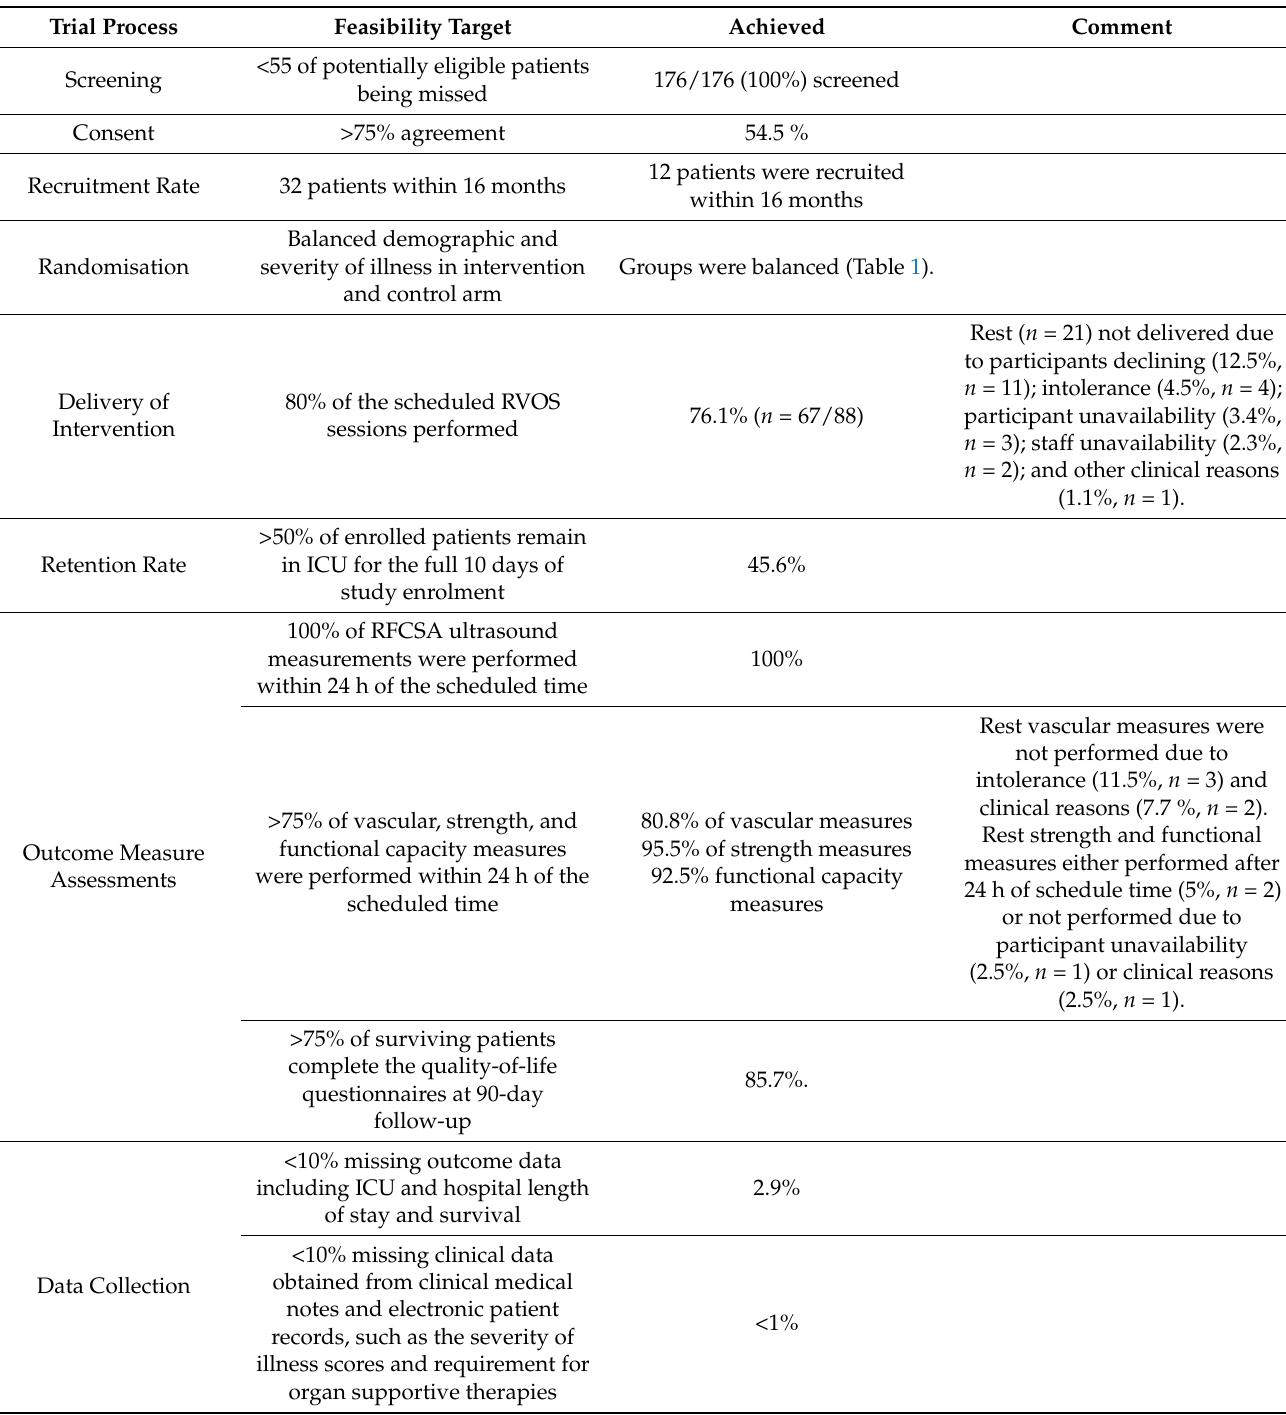
Table 2. Feasibility assessment of trial process in comparison to pre-specified